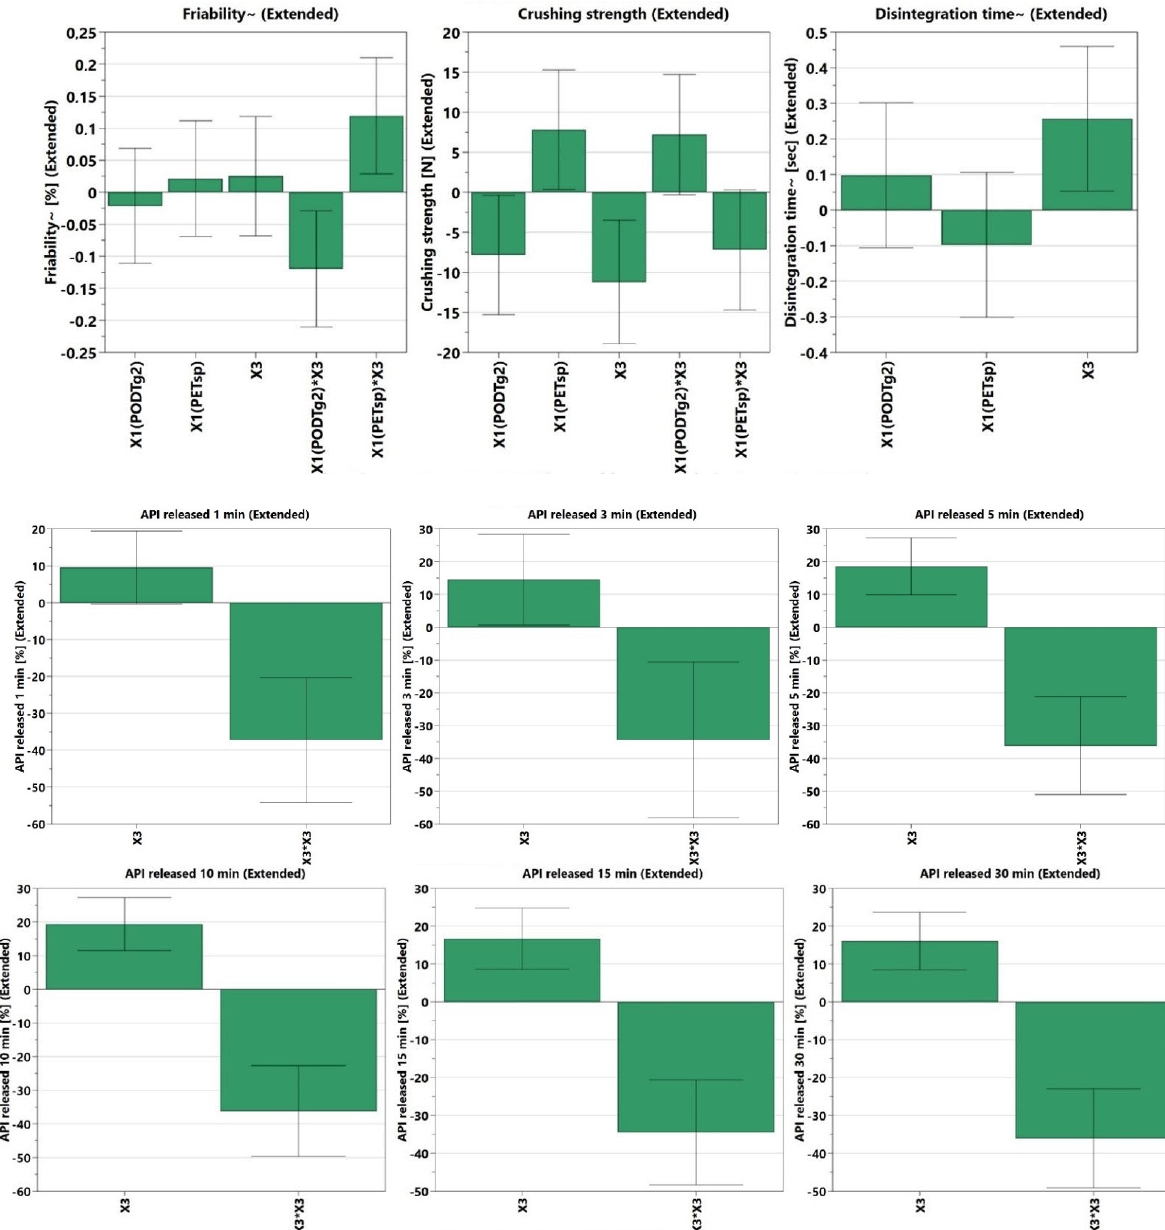
Figure 2. The influence of the independent variables on the dependent factors (Y1–Y9).